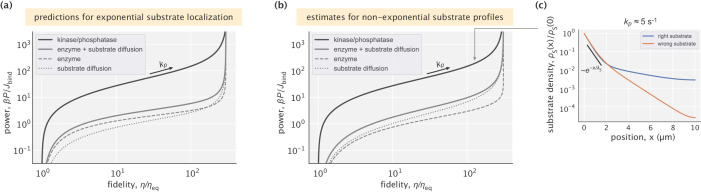
Energetic performance of the kinase/phosphatase–based mechanism.(a) Total dissipation and calculated lower bounds under the assumption of exponential substrate localization. (b) Total dissipation and lower bounds estimated without assuming exponential substrate profiles. In both (a) and (b) kb=1⁢s-1 and Δ⁢εkin=Δ⁢εphosph=10⁢kB⁢T were used. (c) Example profiles of right and wrong substrates for the physiologically relevant dephosphorylation rate kp=5⁢s-1. Exponential decay of the substrate profile with the predicted length scale λS=DS/kp holds in the first ∼2 μm of the compartment.